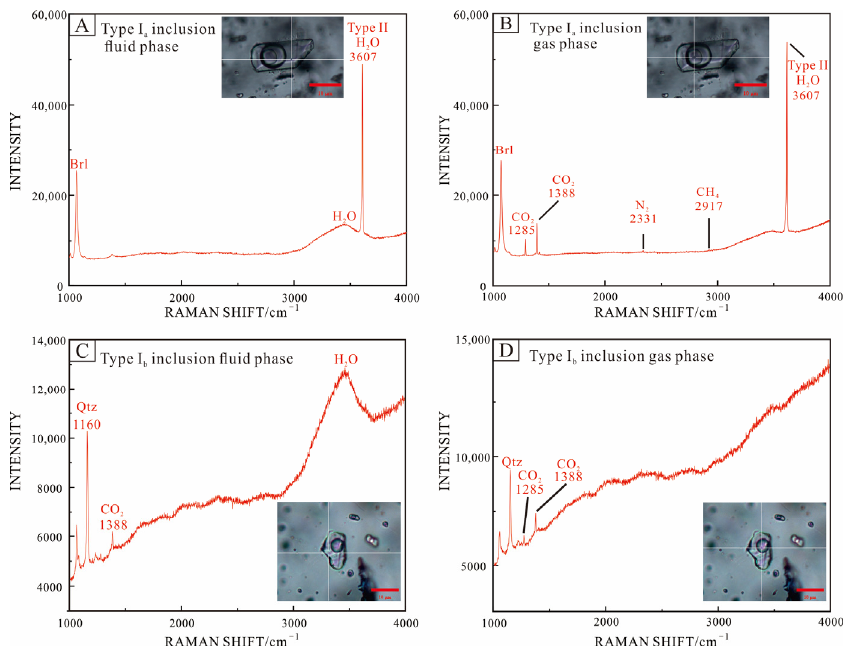
Figure 9. Raman analysis of representative fluid inclusions in beryl ( A , B ) and quartz ( C , D ) from the Dakalasu No. 1 pegmatite vein. ( A , B ) Three-phase CO 2 inclusions (type I a ); ( C , D ) CO 2 -bearing aqueous inclusions (type I b ).